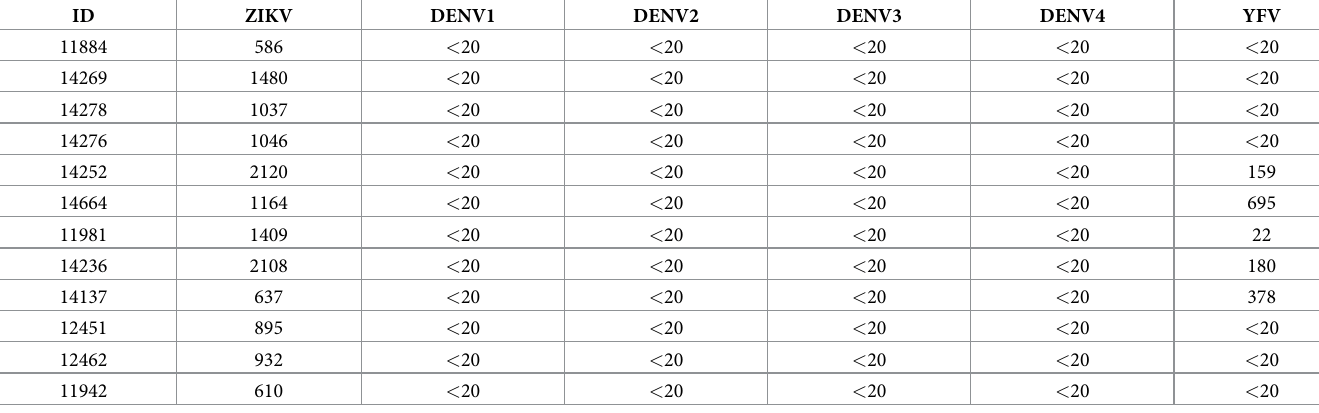
Table 2. Subject neutralization profiles by fold serum dilution yielding 50% neutralization (FRNT50).